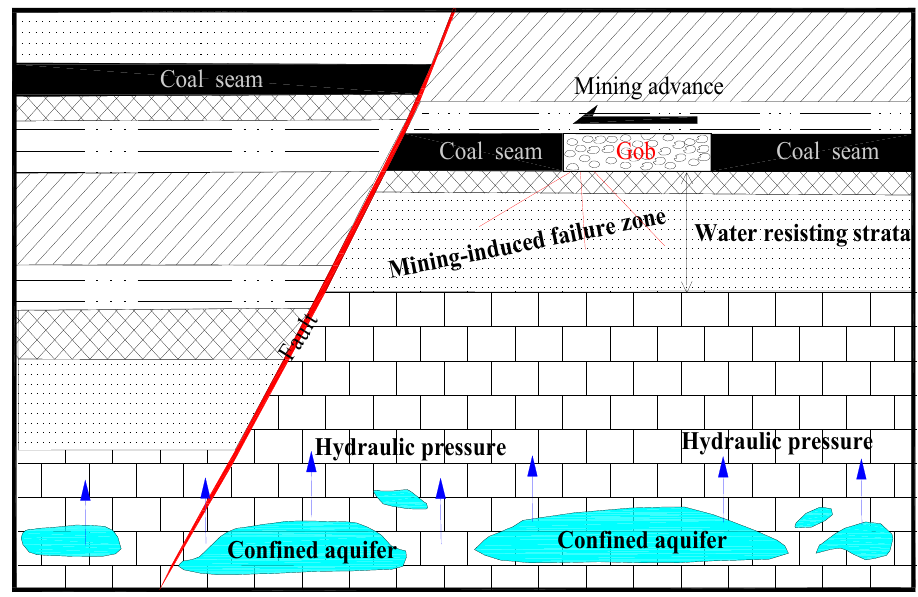
Figure 2. Influencing factors of water inrush from coal floor.